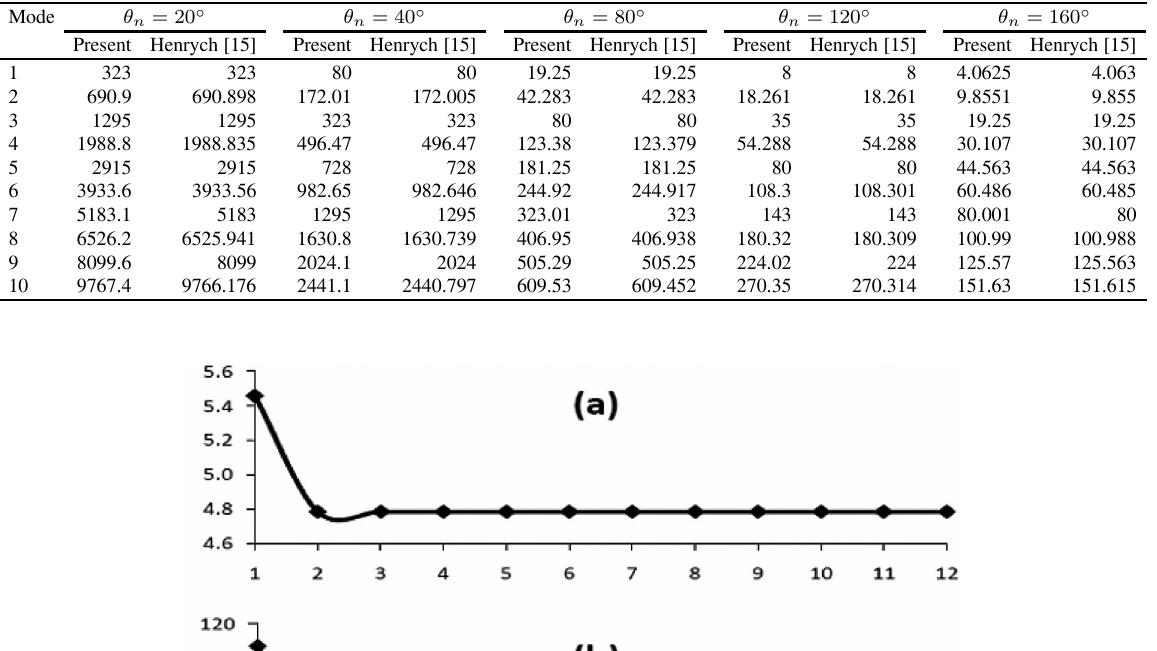
Table 7 Dimensionless natural frequencies of a hinged-hinged uniform arch